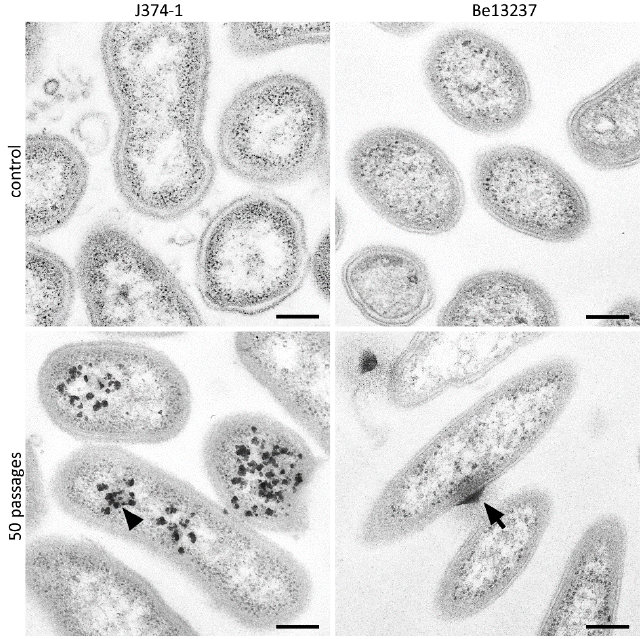
Figure 5. TEM images of Porphyromonas gingivalis J374-1ATCC 33,277 and Tannerella forsythia Be13237 after 50 passages on agar plates containing subinhibitory concentrations of taurolidine in comparison to its control. P. gingivalis J374-1 (a strain becoming more resistant to taurolidine) shows dense particles within cytoplasma (arrowheads). For T. forsythia Be13237 (a strain becoming more susceptible) dense structures at the cell wall surrounded by a halo (arrow) were be found. Scale bars: 200 nm.